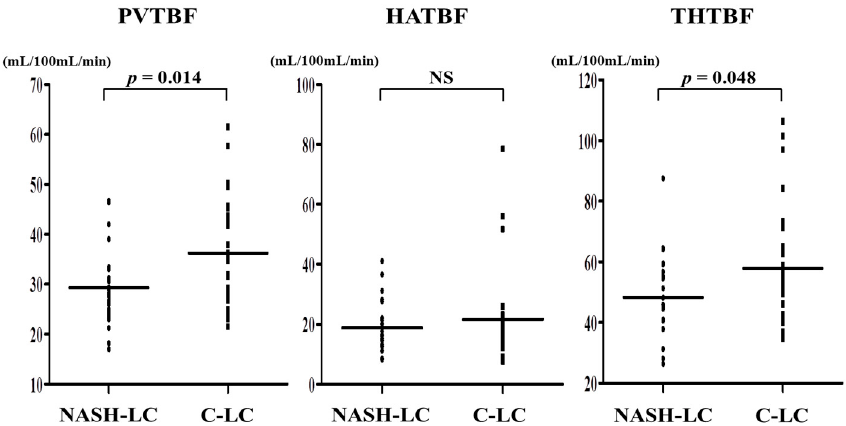
Figure 1. Comparison of each TBF at initial LC (Child-Pugh A) in NASH-LC and C-LC. PVTBF and THTBF are significantly lower in NASH-LC than in C-LC ( p = 0.014, p = 0.048, respectively). HATBF